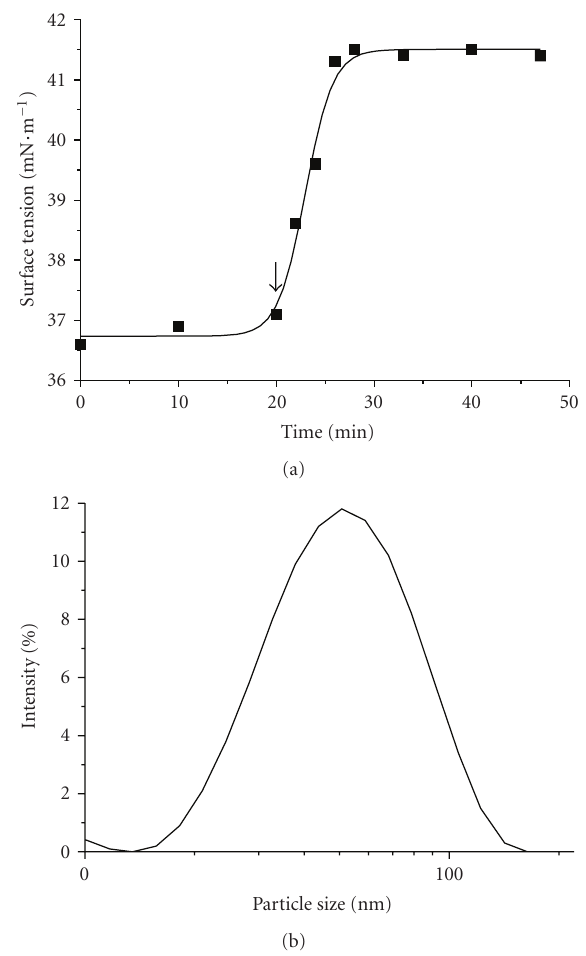
Figure 2: (a) Variation of the surface tension of water-TTAB-PFFO- CF systems during ultrasonication (arrow indicates the beginning of ultrasonication). (b) Intensity weighed particle size distribution of PFFO nanoparticles.